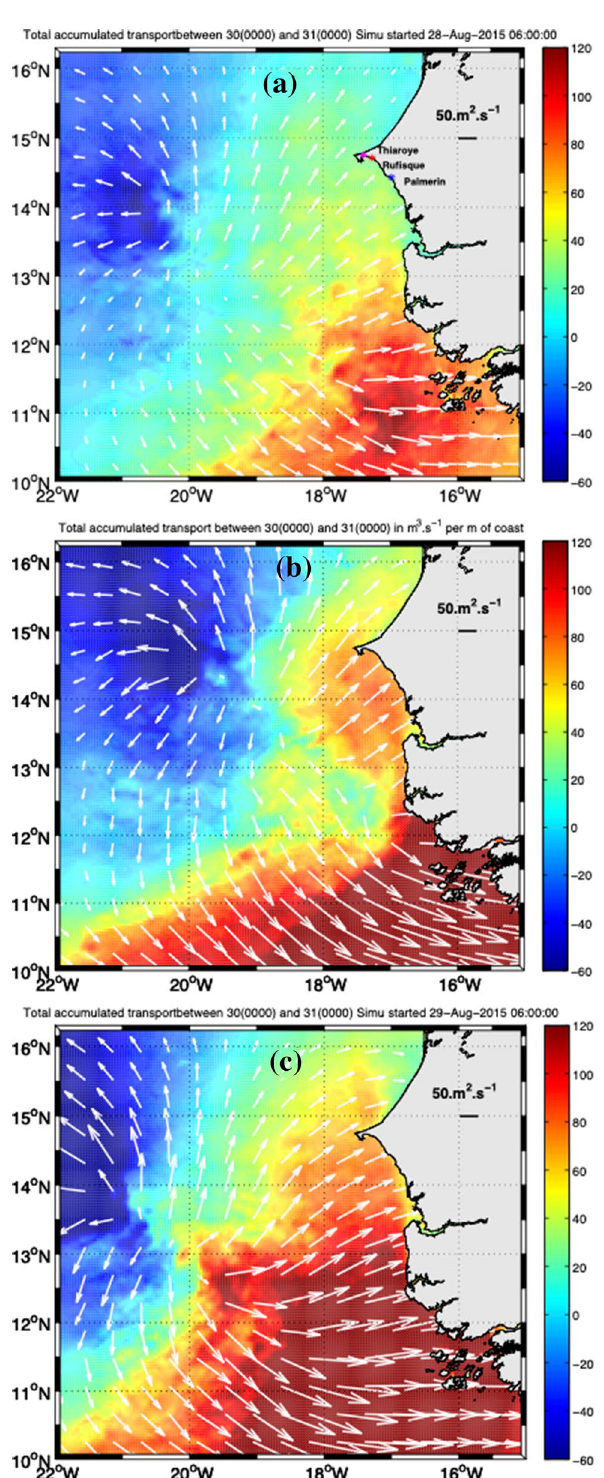
Fig. 8 Zonal component of the accumulated Ekman transport in color from 30th to 31st august for 2A (top), 2B (middle) and 2C (bottom). Total accumulated Ekman transport is represented in vec-